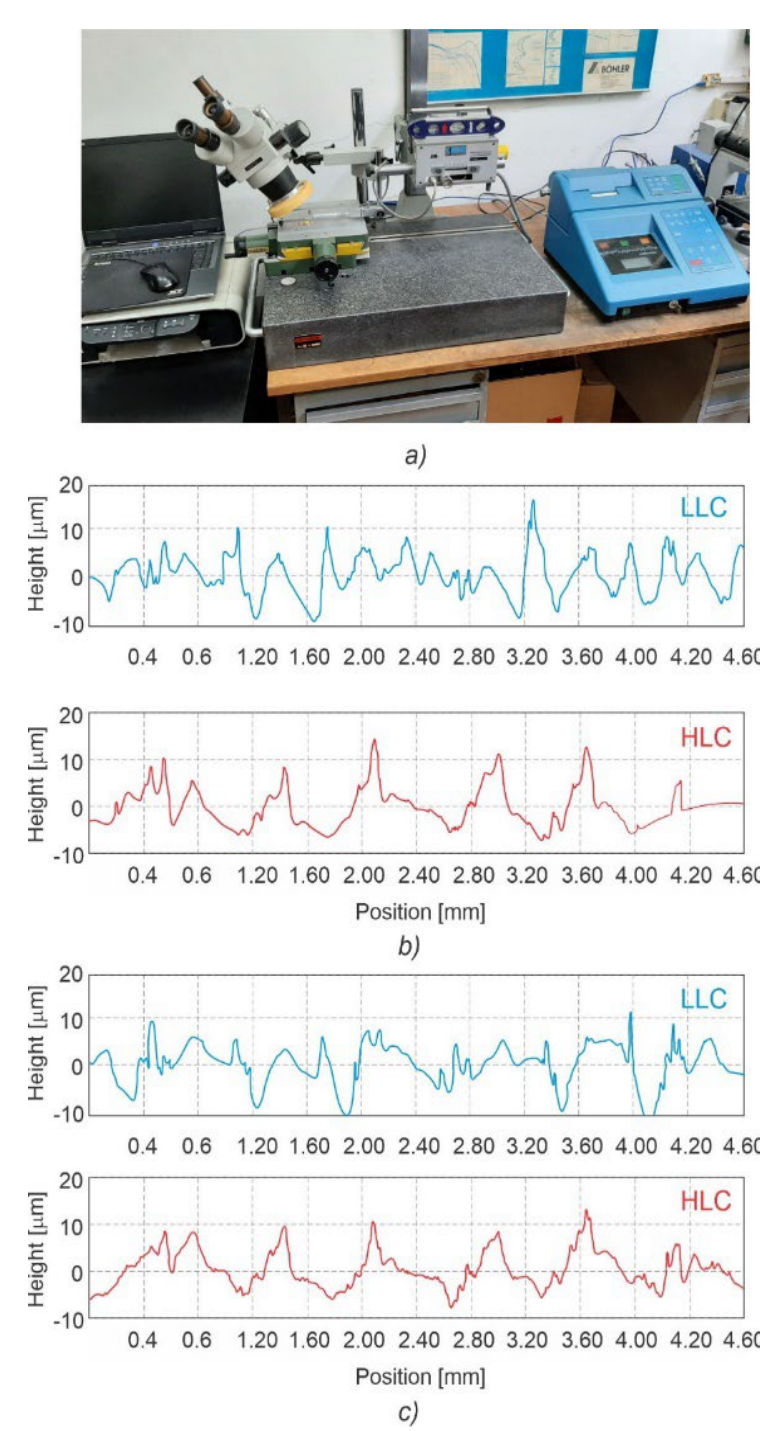
Figure 7. Positioning of the stereo microscope during measurements ( a ), and the two selected pairs of LLC and HLC scaffold plate profiles ( b , c ), which exhibit a visible difference in the width of mean profile elements (Rsm).